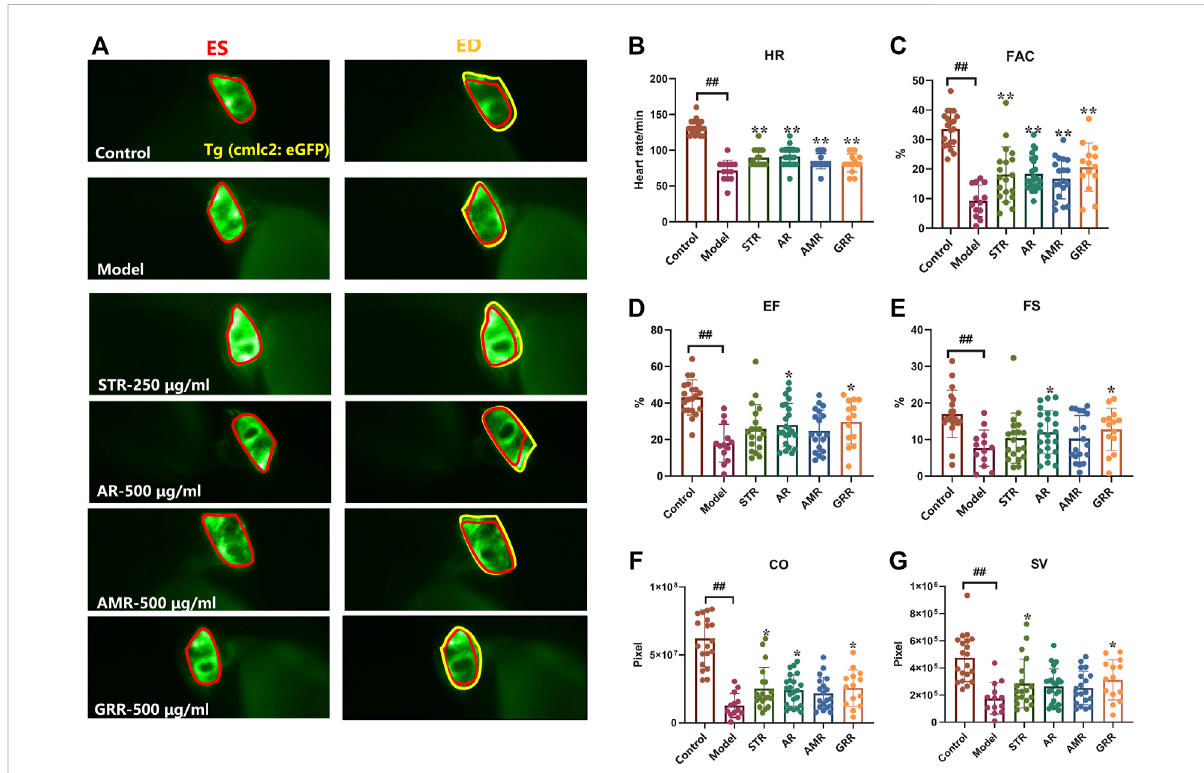
FIGURE 3 The therapeutic effects of botanical drugs on verapamil-induced heart failure model in zebra fi sh. Representative images (A) and quanti fi cation (B – G) of cardiac function in Tg (cmlc2: eGFP) zebra fi sh larvae treated with botanical drugs. N ≥ 15. # p < 0.05 vs . Control, ## p < 0.01 vs . Control, * p < 0.05 vs . Model, ** p < 0.01 vs .